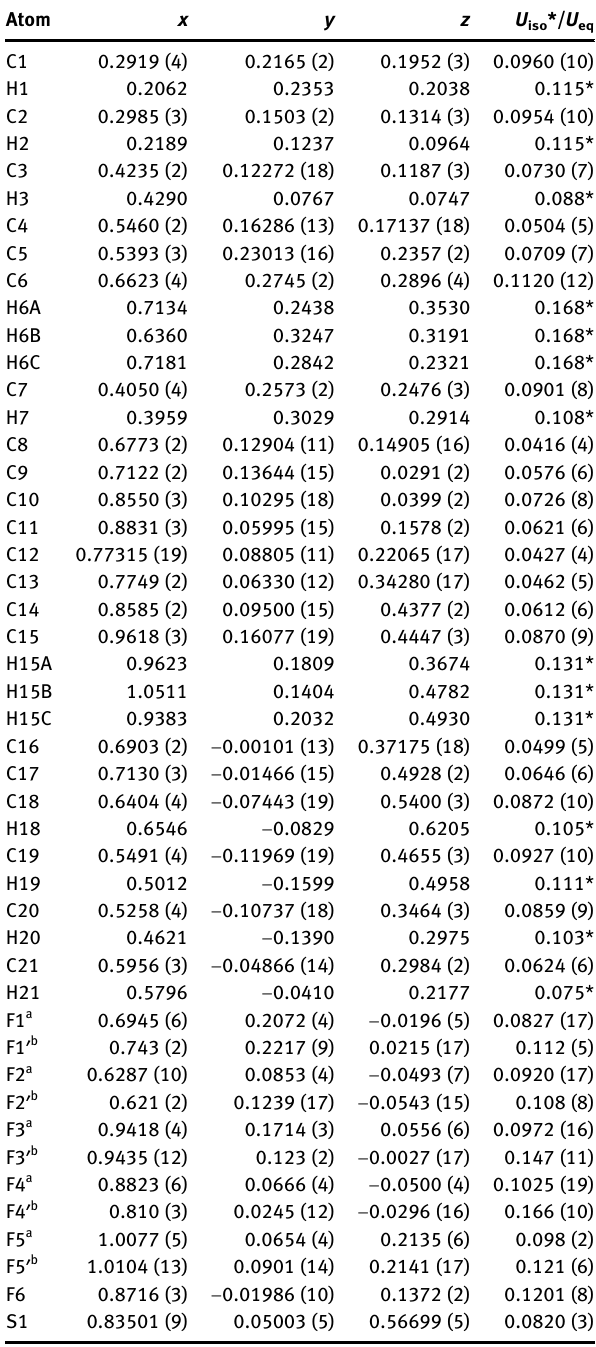
diarylethene systems is composed of fi ve-membered het- erocyclic rings or the combination of fi ve-membered aryl